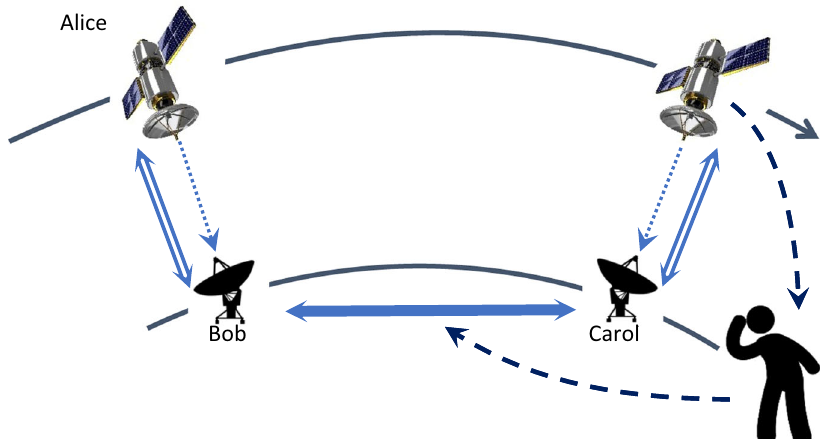
Fig. 2 Long-range quantum key exchange with an untrusted satellite. In the ARQ19 patent, the processing of the keys is only partly done through the public discussion channels with the satellite. The fi nal processing is done directly between Bob and Carol (full arrow). However, if the satellite is untrusted, the data from the satellite can leak to an eavesdropper on the ground (dashed line). The discussion channel between Bob and Carol therefore must be protected from the eavesdropper. It must be a con fi dential